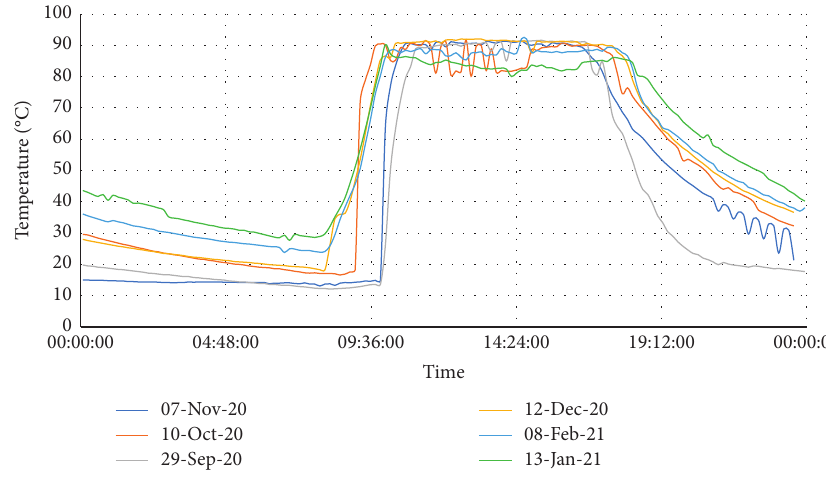
Figure 4: Evaporator SW temperature versus